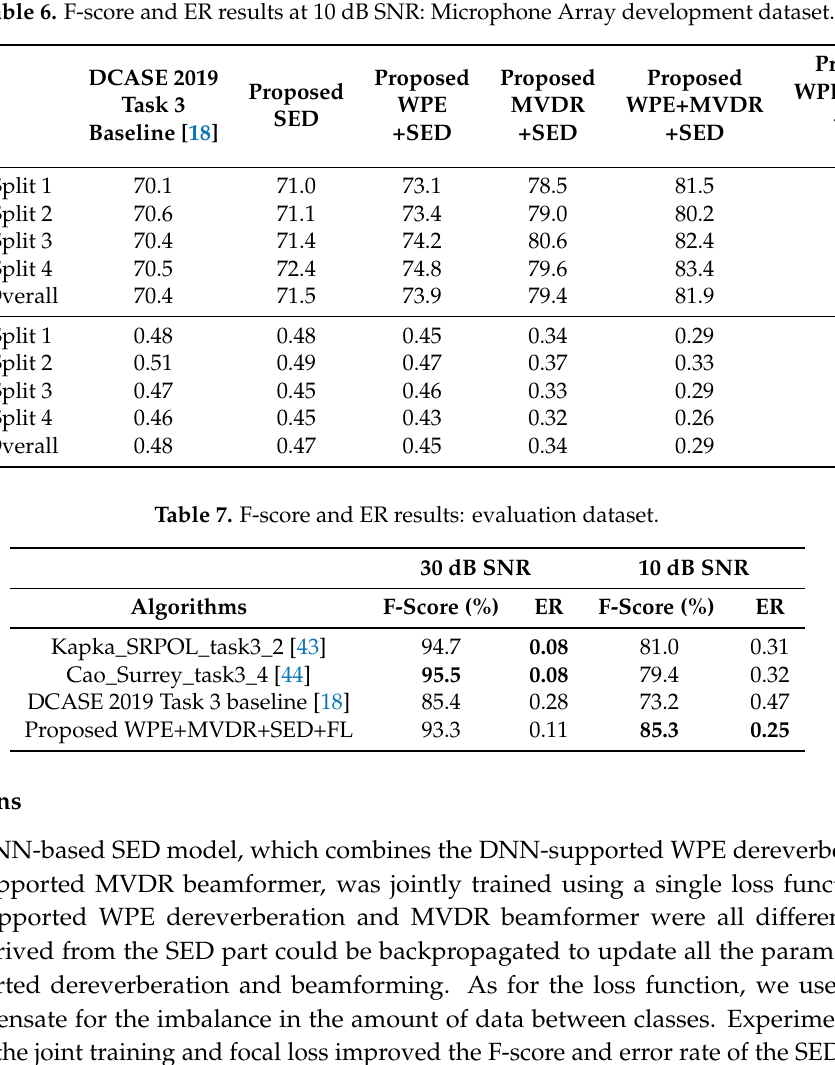
Table 6. F-score and ER results at 10 dB SNR: Microphone Array development dataset.